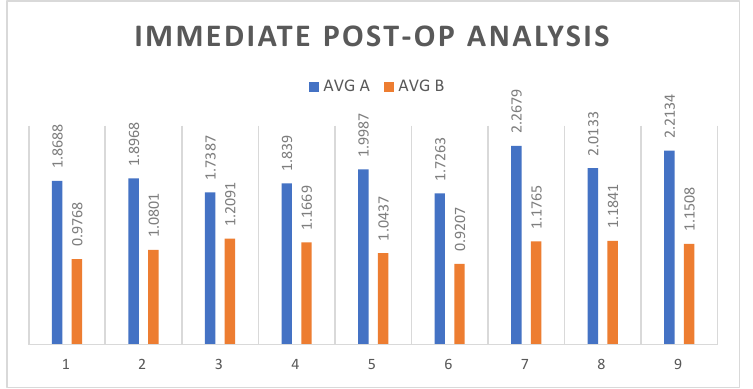
Figure 7. Discrepancy values of nine medial orbital wall points between immediately post treatment affected orbit image and affected orbit at 6 months post treatment for Group A compared with Group B.